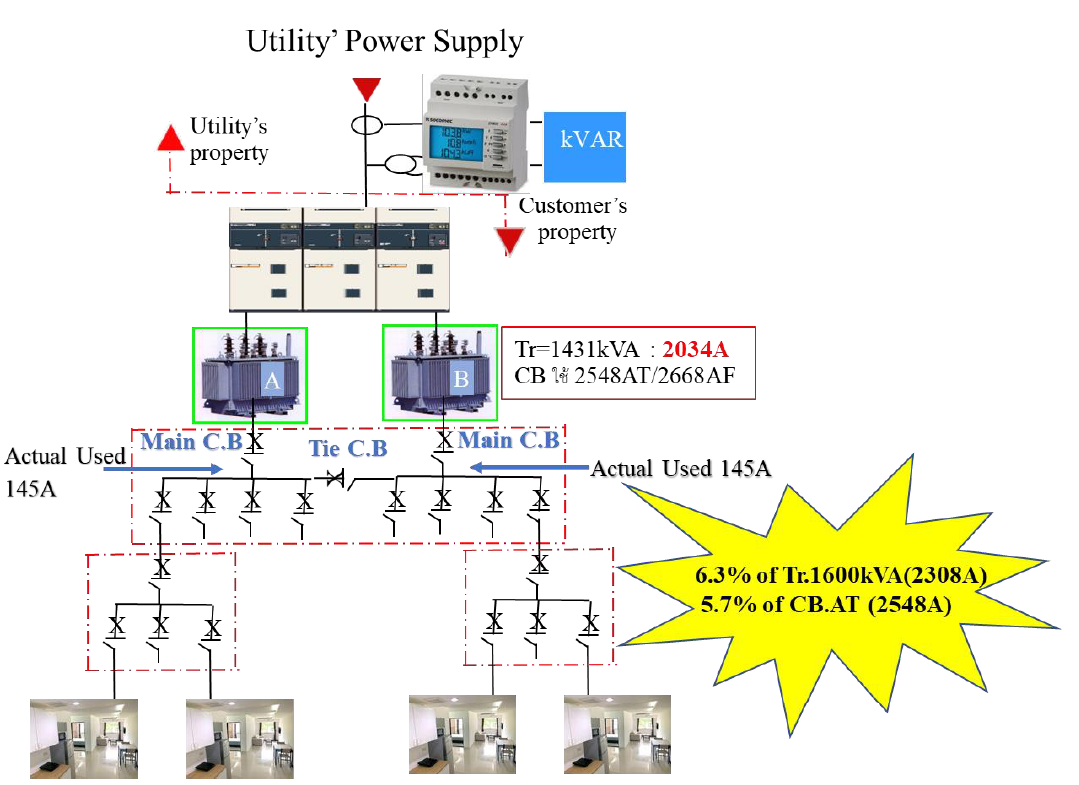
Figure 5. Single line diagram displaying utility of power supply.